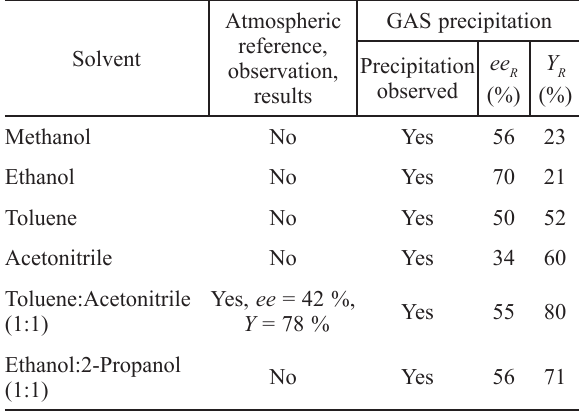
Table 2 – Effect of solvent on salt formation at 12 MPa, 40 °C, 8.8 g